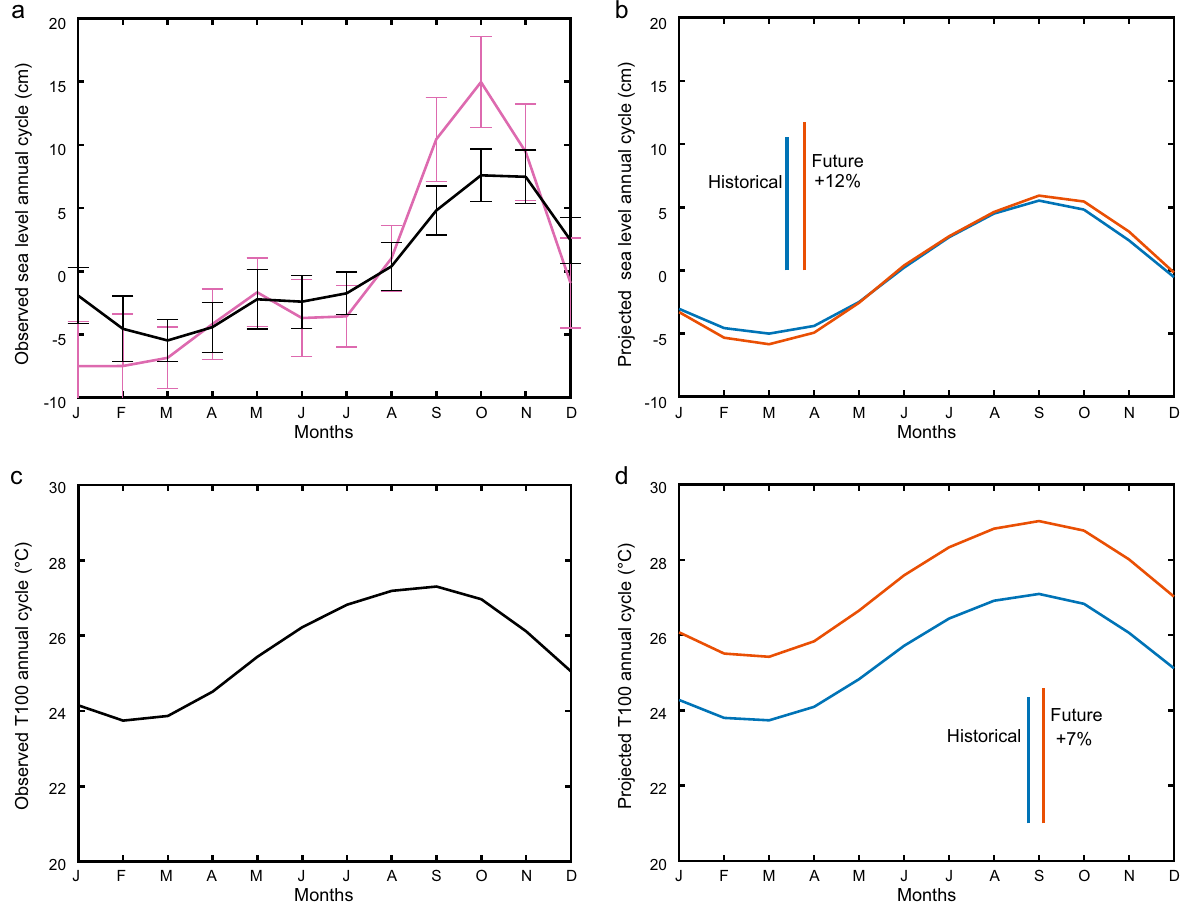
Fig. 2 The annual cycle of sea level (cm) and T100 (°C) around the City of Miami, Florida from observations and the CMIP5 multi-model mean. a , c The sea level and T100 annual cycles, respectively, for ORA-S5 (black) averaged over the 1° ocean grid box nearest the Virginia Key tide gauge (purple; 25.7°N, 279.8°E). The seasonally-dependent interannual variability of the tide gauge and ORA-S5 are also shown in ( a ) (bars; ±0.5 standard deviation). b , d The sea level and T100 annual cycles for the historical (blue) and RCP8.5 (orange) experiments averaged over the nearest 1° ocean grid to the tide gauge for each model. Sea level annual cycles are normalized to have a mean of zero ( a , b ). The vertical lines indicate the magnitude of the annual ranges during the historical and future periods ( b , d